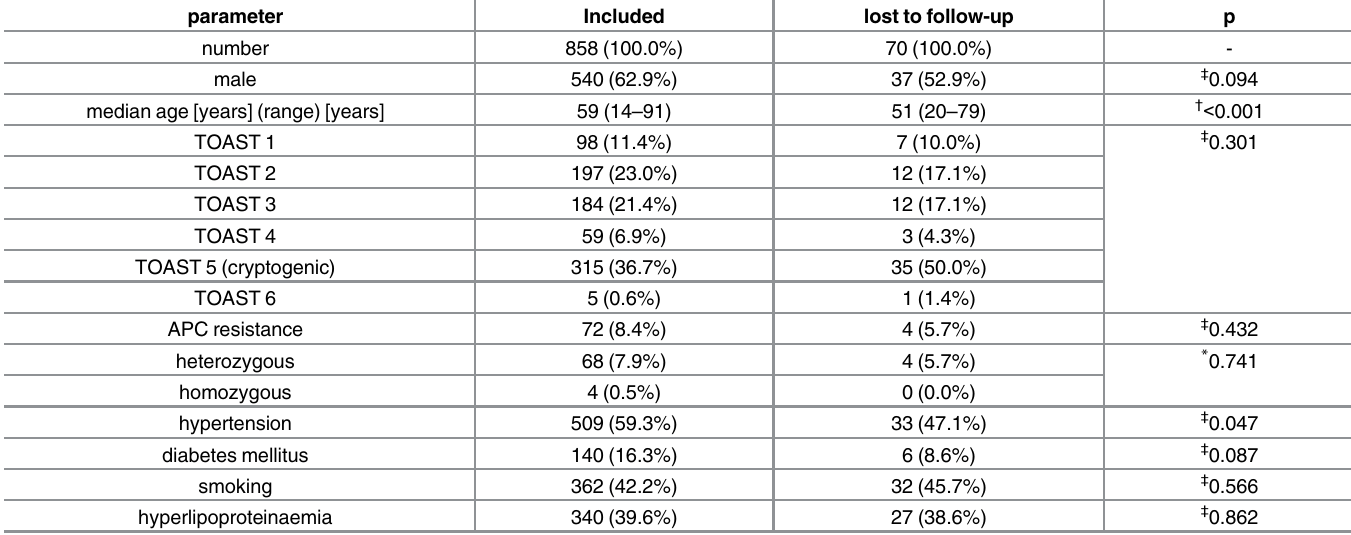
Table 1. Baseline data of considered patients.